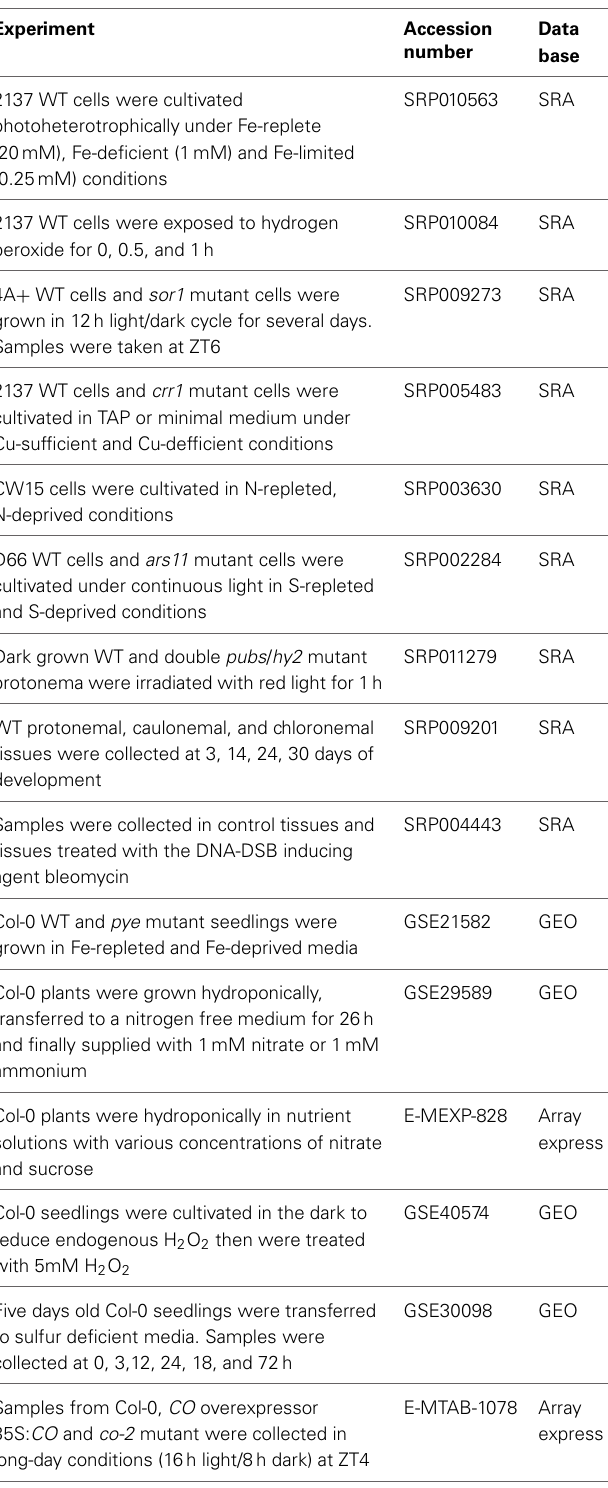
Table 3 | Description of the experiments and datasets employed in this